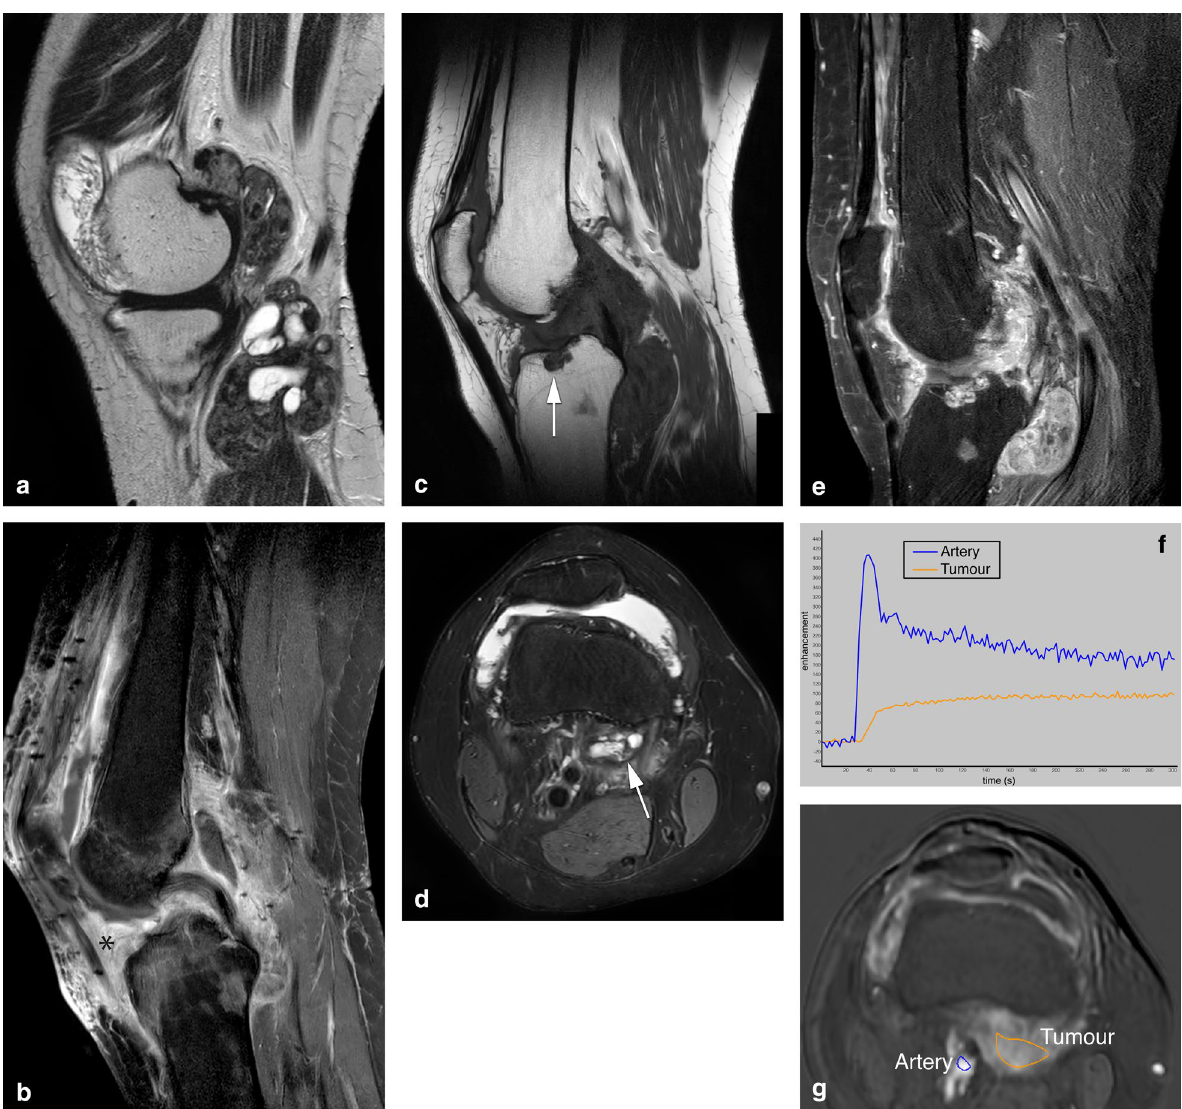
Fig. 2 A case of D-TGCT demonstrating pre and post synovectomy findings on MRI. a Sagittal T2 weighted image shows multilobular posterior tumour with low signal intensity, and adjacent cyst-like components present within tumour in the popliteal cyst. Anterior, in the medial gutter of the suprapatellar recess smaller synovial proliferations are present. b Sagittal T1 SPIR post contrast performed 3 months after anterior and posterior synovectomy shows surgical clips with metal artefact anterior and posterior in the soft tissues, thickening of the quadriceps tendon, subcutaneous oedema and marked enhancement in Hoffa’s fatpad (asterisk) and along the posterior cortex of the tibia (subpopliteal recess). This mass-like enhancement can be post operative but residual tumour cannot be excluded at this time. MRI performed 3 years post synovectomy: c Sagittal T1 shows a bone erosion centrally in the tibial plateau (arrow). Furthermore, soft tissue masses posteriorly in the knee are present containing foci of low signal intensity. d Axial PD SPAIR shows a typical location of a lesion containing cystic components at the medial retrocondylar recess (arrow). e Sagittal T1 SPIR post contrast demonstrates enhancement of tumour within the tibia plateau erosion and of the posterior mass lesions. Note that Hoffa’s fat pad shows normalisation of fatty signal intensity except for a rim of tumour enhancement in the central synovial recess and inferior infrapatellar recess. f , g Time intensity curve of the tumour based on the region of interest (orange line) of the lesion demonstrated in d , showing early enhancement within 10 s after the artery (blue line) followed by a plateau phase (type III curve suggestive of a benign